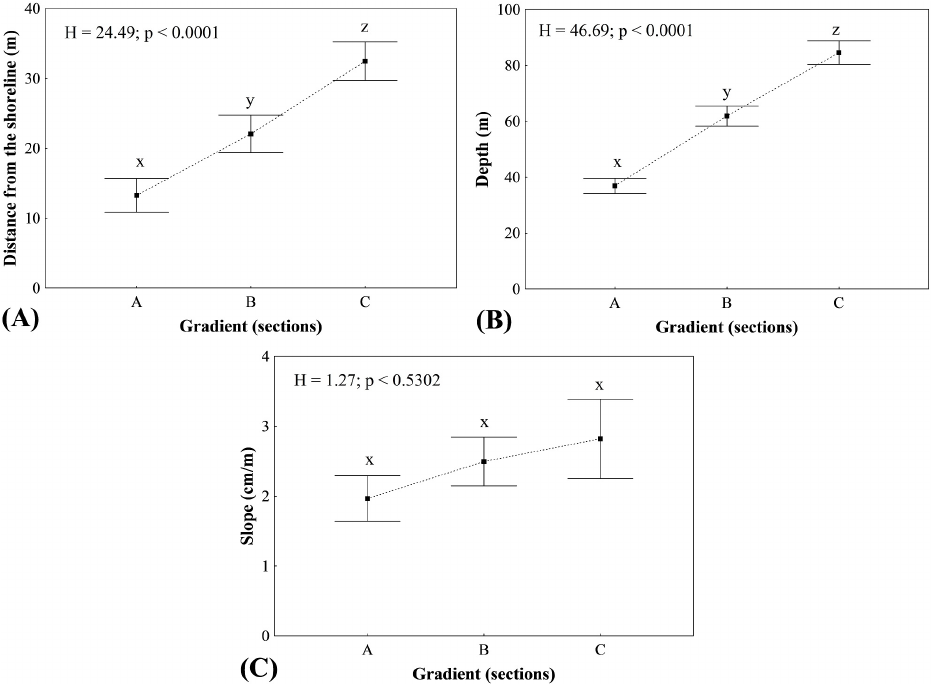
Figure 3. Variation in morphometric variables (distance from the shoreline (A), depth (B) and slope(C)) along the depth gradient (sections A, B and C). Dots are mean values and bars represent the standard error. Statistical differences among sections were tested with non-parametric ANOVA (Kruskal-Wallis, H) and Mann-Whitney pairwise comparison (different